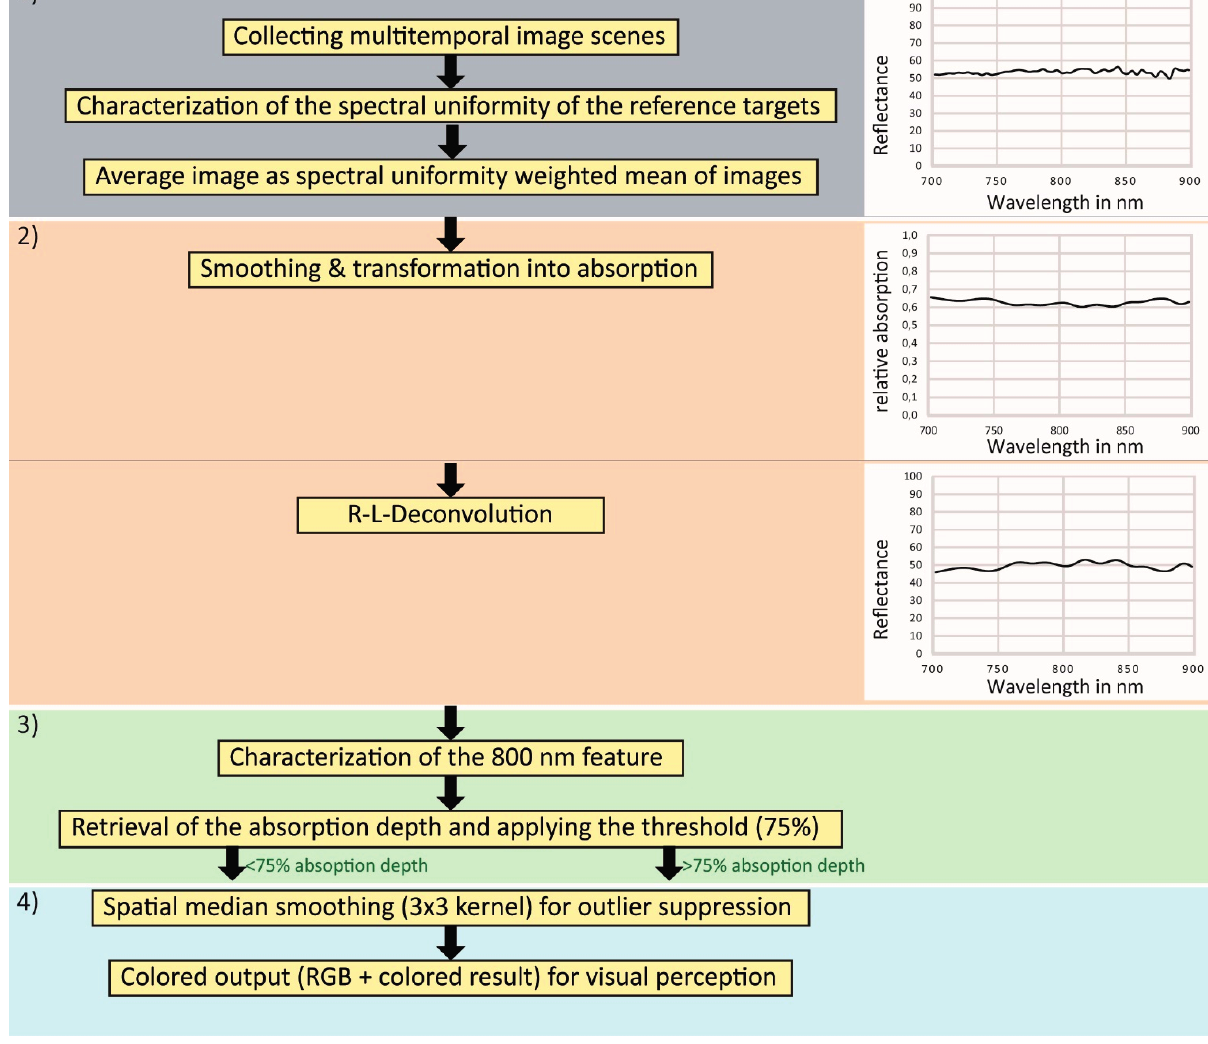
Figure 4. Flow Chart of the REE mapping approach showing the four main steps of its application. The first step is the collection of the multitemporal data cube and